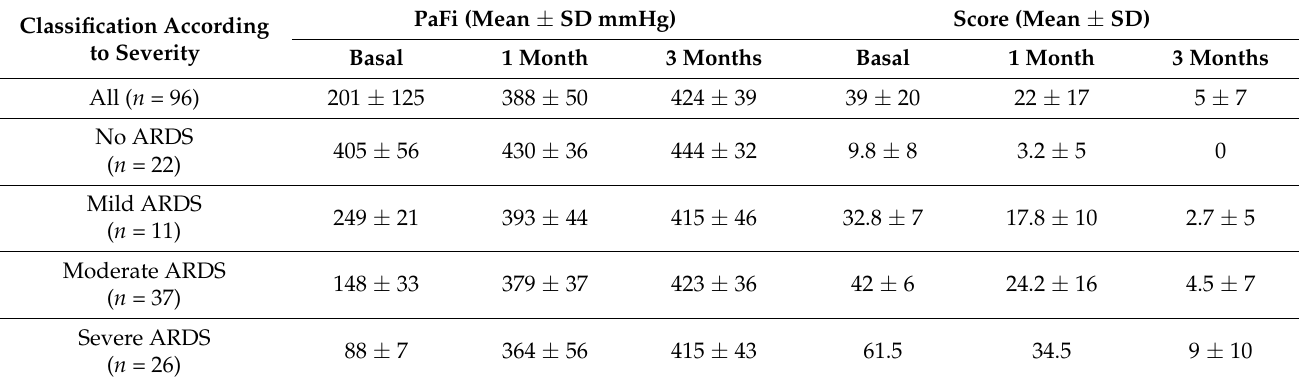
ARDS: Acute respiratory distress syndrome; PaFI: PaO 2 /FiO 2 ; SD: Standard